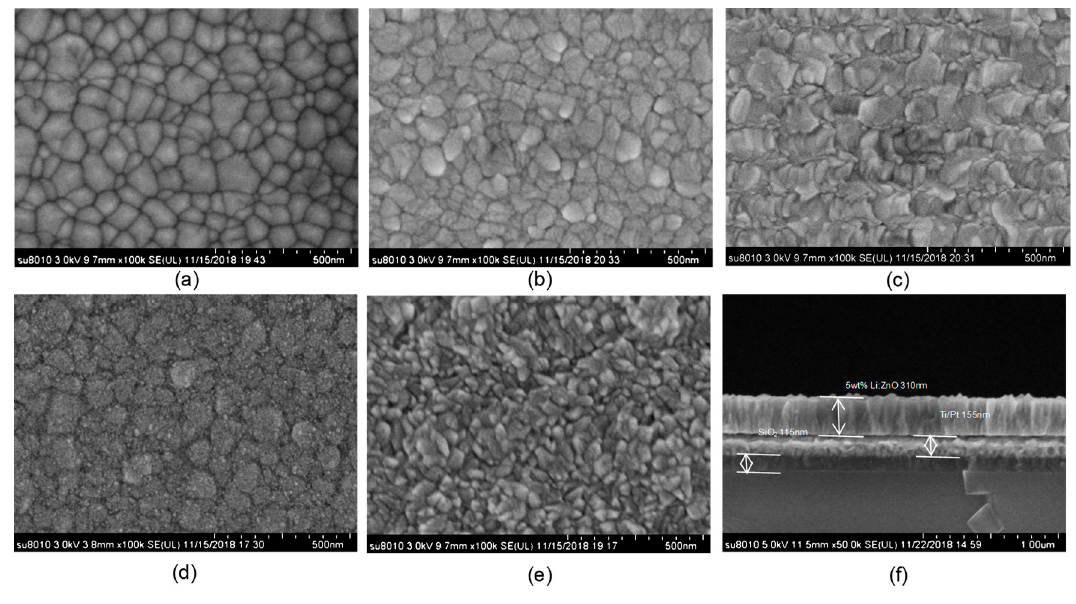
Figure 6. The SEM photographs: ( a ) pure ZnO; ( b ) 3 wt% LZO; ( c ) 5wt% LZO; ( d ) 8 wt% LZO; ( e ) 10 wt% LZO; ( f ) cross-sectional morphology of the 5 wt% LZO.